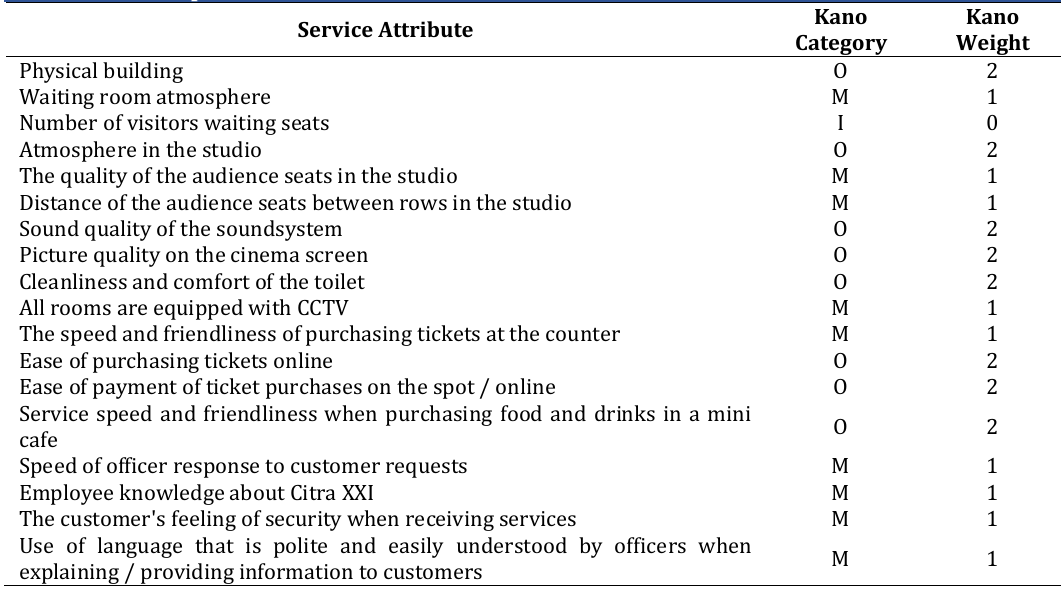
Table 6: Raw importance